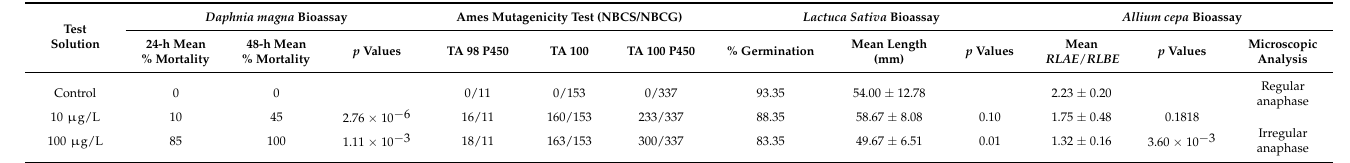
Table 2. Summary of exposure risk evaluation of